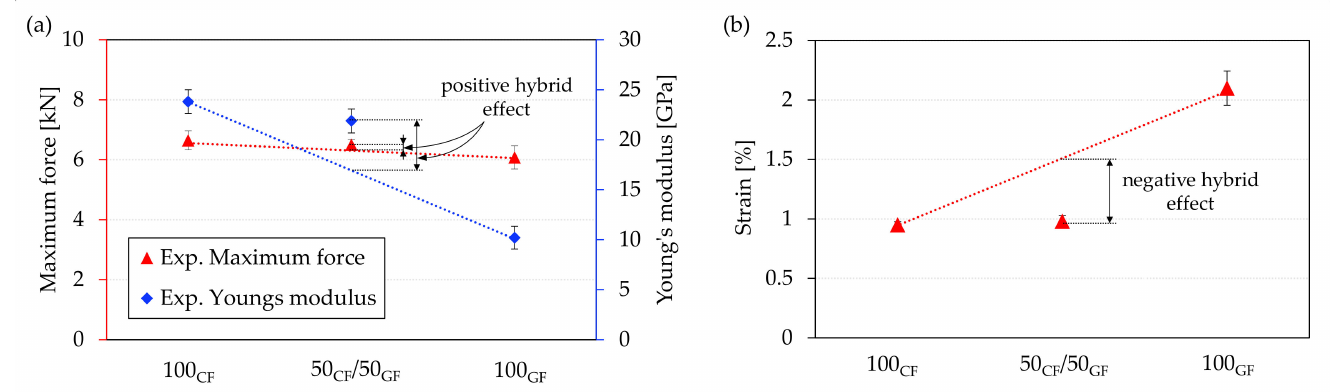
Figure 15. Positive and negative hybrid effects: ( a ) maximum force and Young’s modulus and ( b ) failure